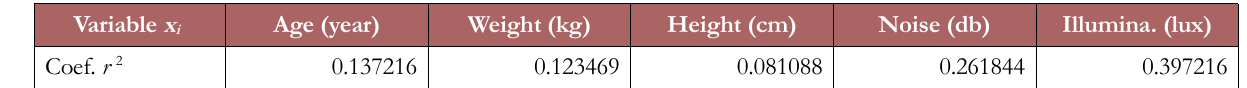
Table 1. Correlation values between independent and dependent variables